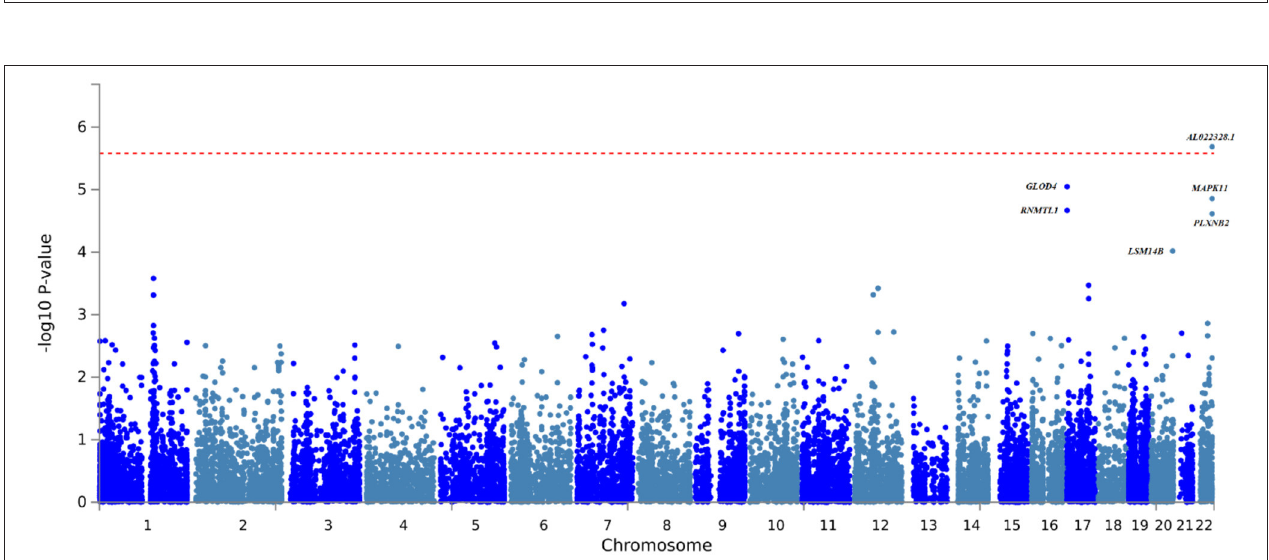
FIGURE 2 | Gene-based association testing results obtained from the FUMA analysis of the TBM vs. healthy control GWAS summary statistics.